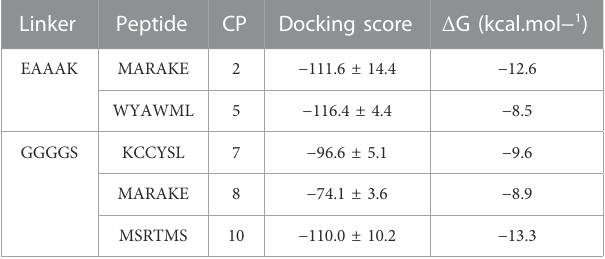
TABLE 3 Docking scores and Δ G of CPs obtained from the HADDOCK and PRODIGY